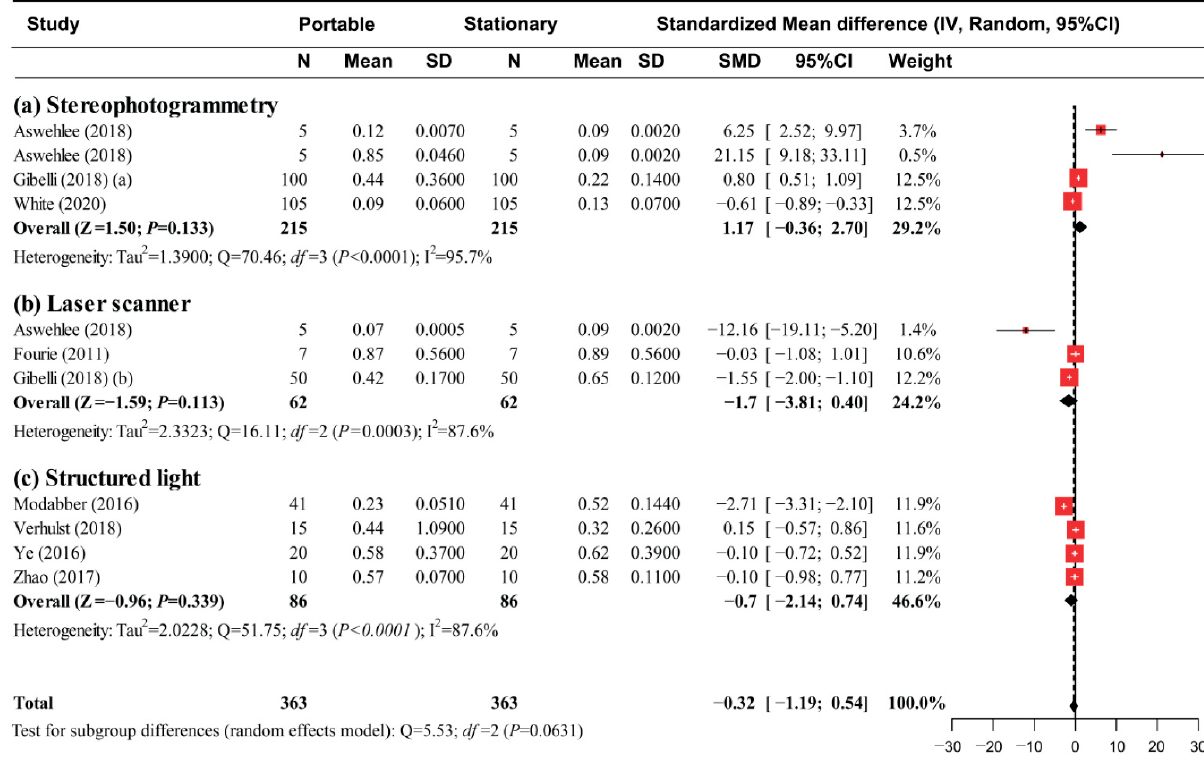
Figure 5. Funnel plot for the publication bias of all studies included in the meta-analysis.